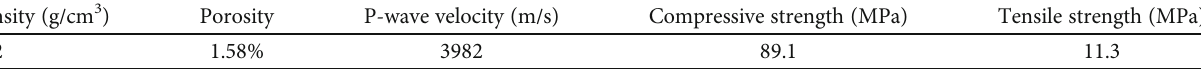
Table 1: The physical and static mechanical parameters of deep